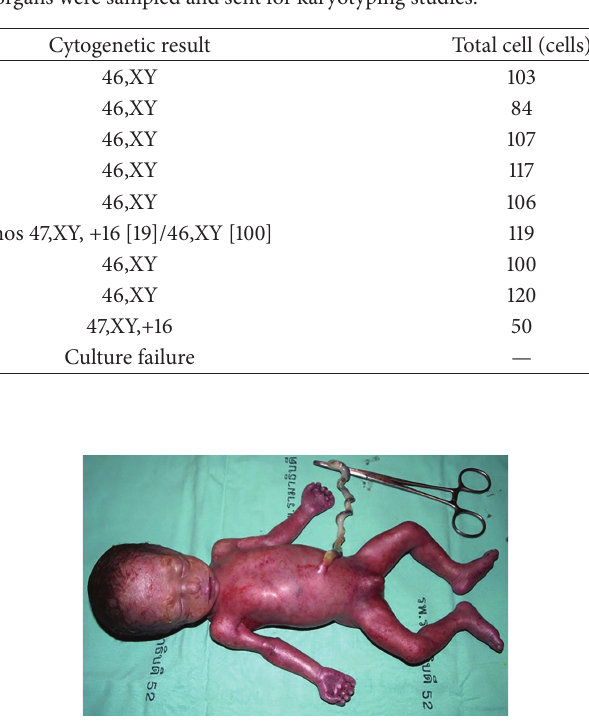
Table 1: Cytogenetic analysis: several tissues from various organs were sampled and sent for karyotyping studies.